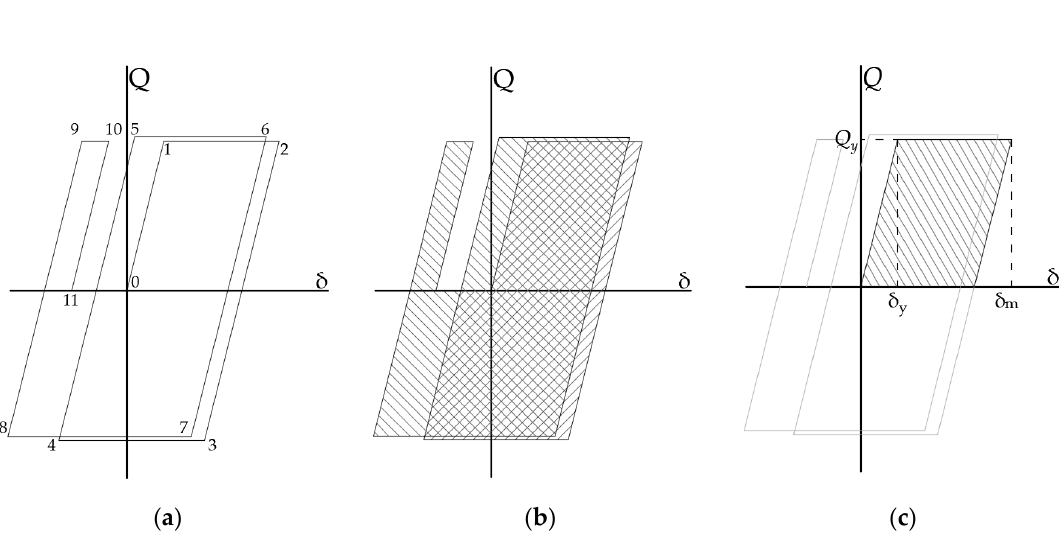
Figure 1. Energy dissipation in an elastoplastic system: ( a ) Cyclic force-displacement Q- δ curve; ( b ) Energy dissipated by yielding E H ; ( c ) Energy dissipated in a quarter-cycle at maximum displacement.